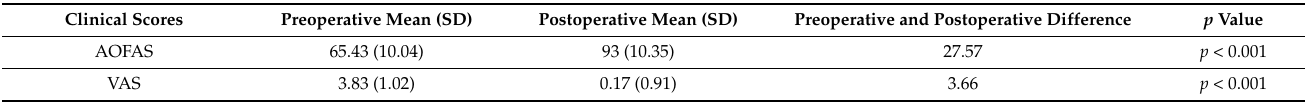
Table 3. Results of the pre- and postoperative clinical scores.